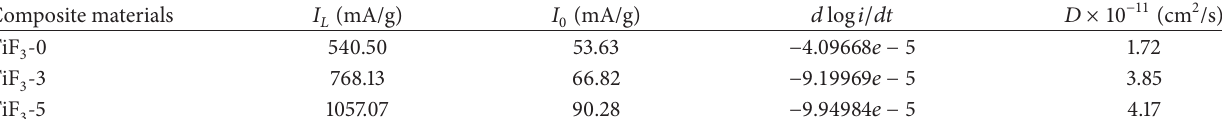
( 𝑦 = 0, 3, 5 ) composite materials polarization fitting results. 3